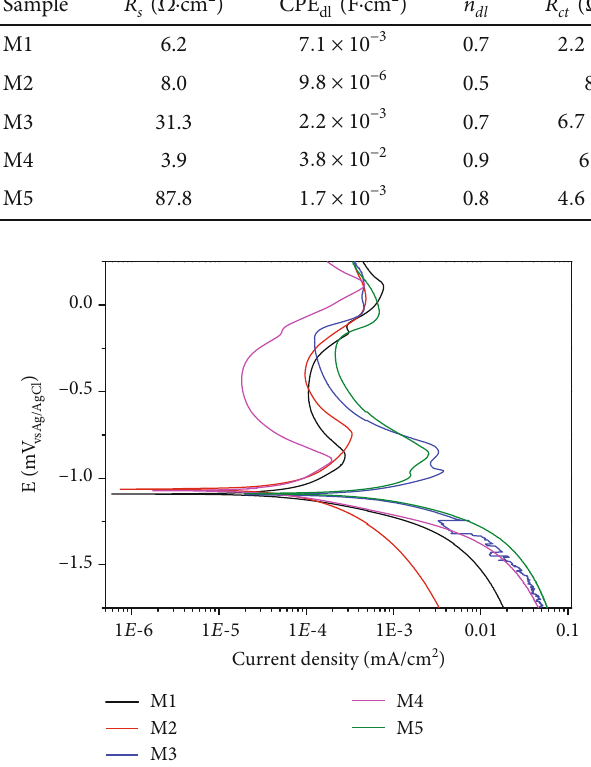
Figure 10: Polarization curves for aluminum-based alloy doped with Mn and Co after heat treatment at 1100 ° C immersed in 3 M